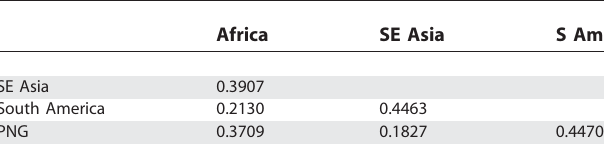
Table 1. Pairwise F ST of Subpopulations from Different Regions of the